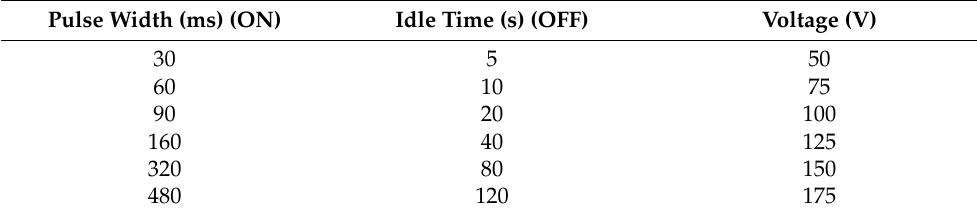
Table 1. List of possible RF pulsed transmission mode waveform parameters protocol settings: pulse amplitude, pulse width and idle time (no-transmission for allowed idle cooling time). Pulse Width (ms)